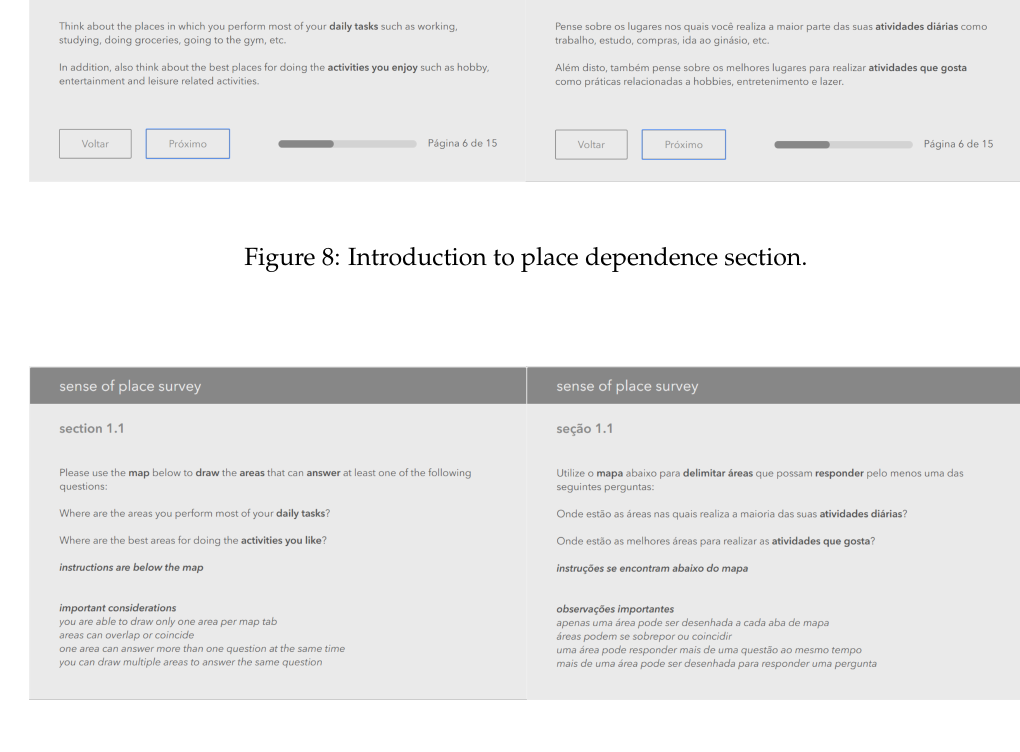
Figure 9: Map-based question for place dependence.